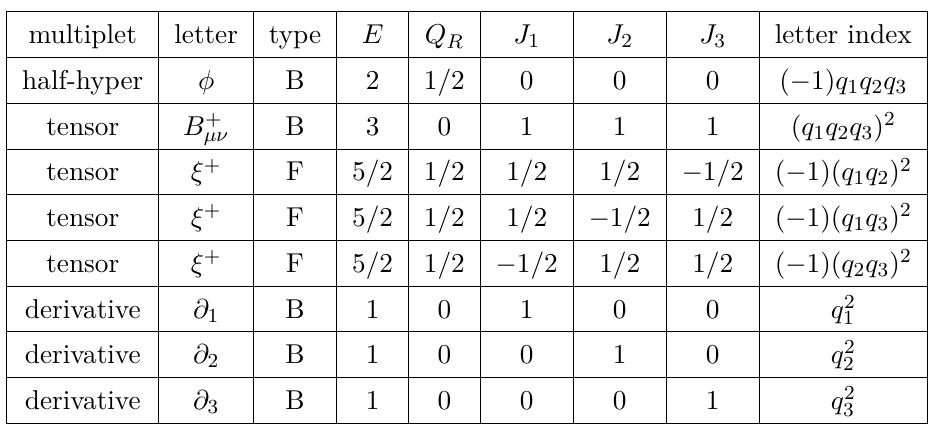
Table 3 . BPS letters in 6d multiplets. Type denotes a boson/fermion statistics, and f denotes a single particle index of the BPS letter. The fugacities are defined as q I = e − ω I / 2 . Note that ( − 1) in the single particle index should be also treated as a